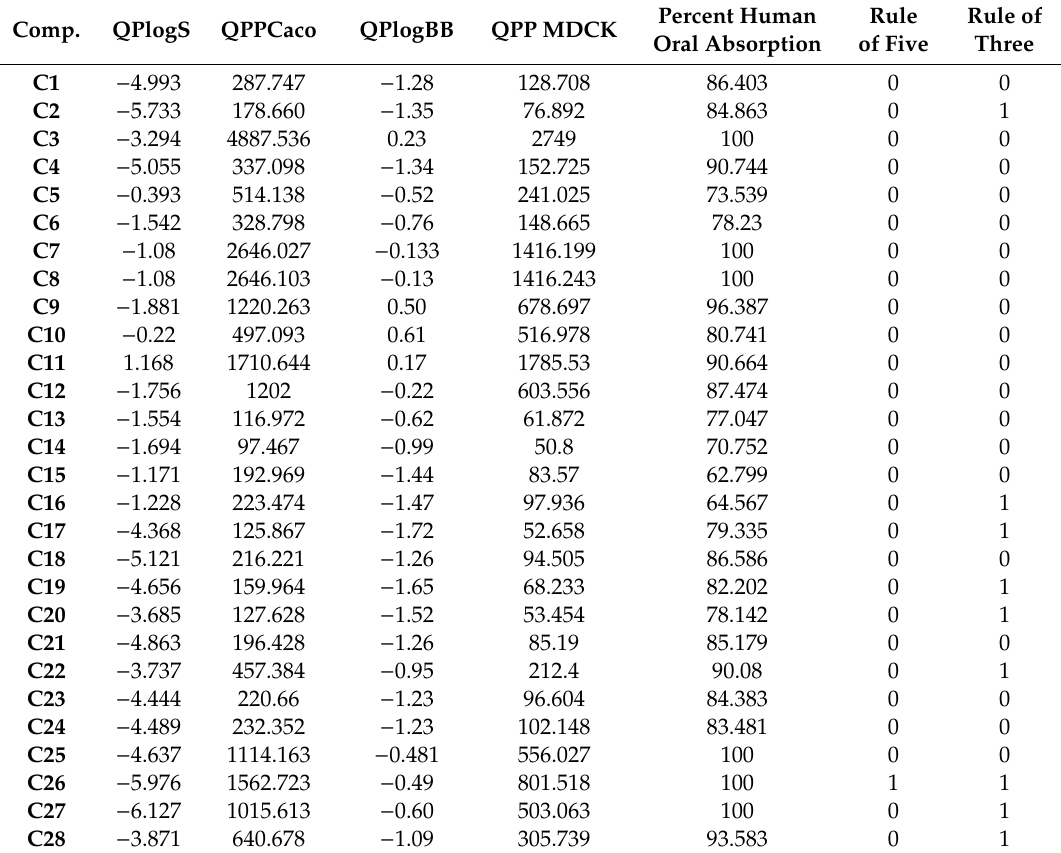
Table2. Predictionofpoorabsorption, distribution, metabolism, andexcretion(ADME)andblood–brain barrier (BBB) properties using QikProp.